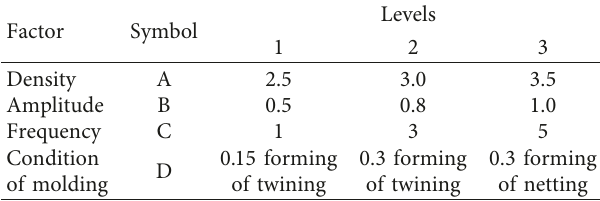
Table 5: Orthogonal test factors and their level.